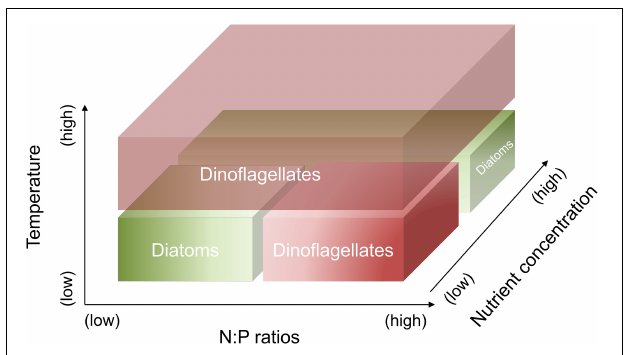
FIGURE 1 | Hypothetic responses of diatoms vs. dinoflagellates to the changes in temperature, N:P supply ratios and nutrient concentrations. Dinoflagellates have the competitive superiority at high temperature, as well as at combined conditions of low temperature, high N:P supply ratios and a low nutrient regime. Diatoms have the competitive superiority at combined conditions of low temperature, low N:P supply ratios and a low nutrient regime, as well as at low temperature and a high nutrient